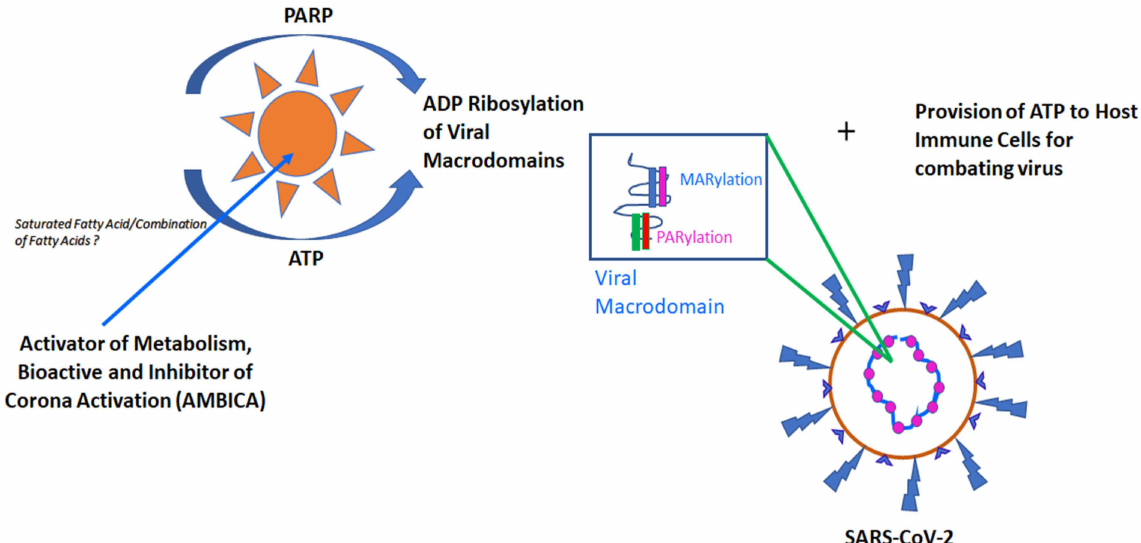
Figure 1. An ideal agent should be an activator of metabolism and bioactive with the capability of inhibiting corona activation (AMBICA). A specific saturated fatty acid or combination of same in specific proportion could be the best fit to act as AMBICA. This agent should be able to provide ATP for cellular fueling, especially for host immune cells, and provide the initial breakdown product of ATP, i.e., ADP as substrate for PARP-mediated MARylation and PARylation of the SARS-CoV macrodomain. This simultaneous property of providing a host cell with ATP as a fuel source and ADP for PARP-mediated MARylation and PARylation will help in preventing SARS-CoV multiplication without the host cells getting deprived of